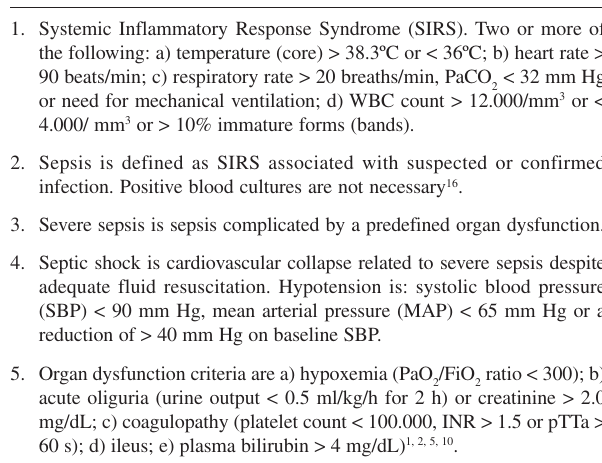
Table 1 - Sepsis definitions